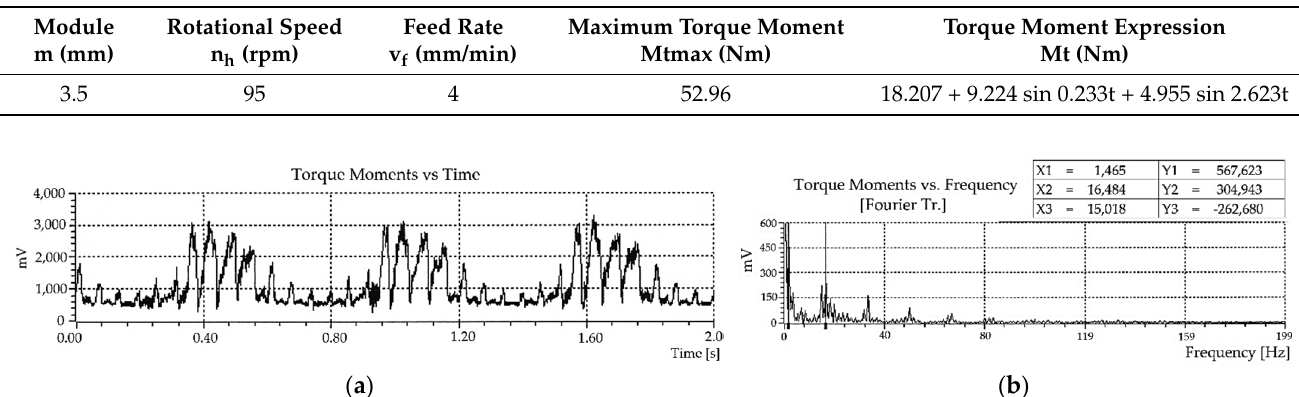
Table 3. The measured numerical results for the torque moment.